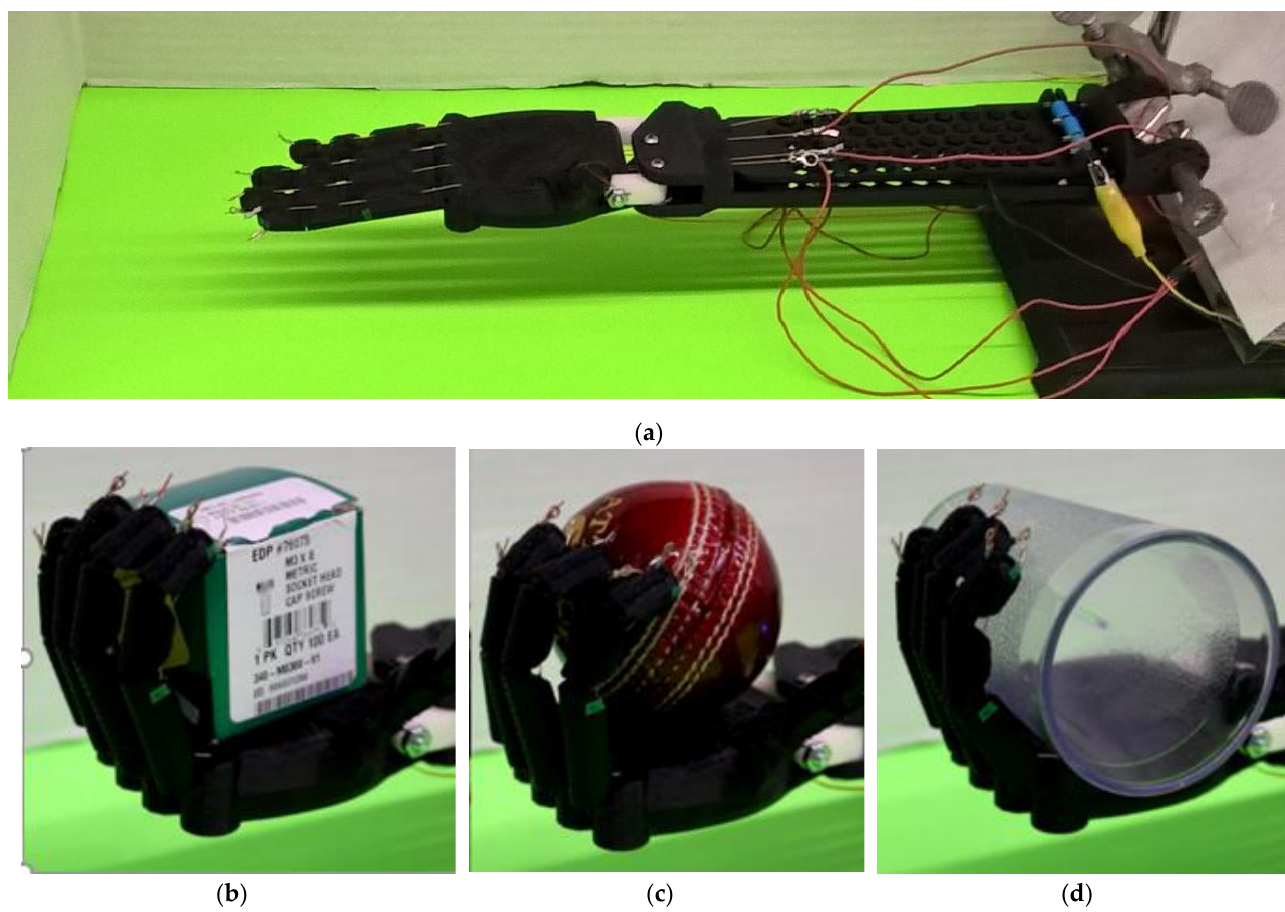
Figure 10. Horizontal grasping of objects from the ARAT kit and others: ( a ) experimental setup; ( b ) box; ( c ) ball and ( d ) cup. In horizontal grasping tests, mass is irrelevant as the palm bears the weight. The fingers prevent the object from rolling out of its grasp (see accompanying videos). The heating cycle used was 0.5 A (flexors) for 4 s (to flex the fingers), followed by 0.2 A (flexors) for 5 s (holding), 1 s off and then 0.5 A (extensors) for 7 s (to extend the fingers).